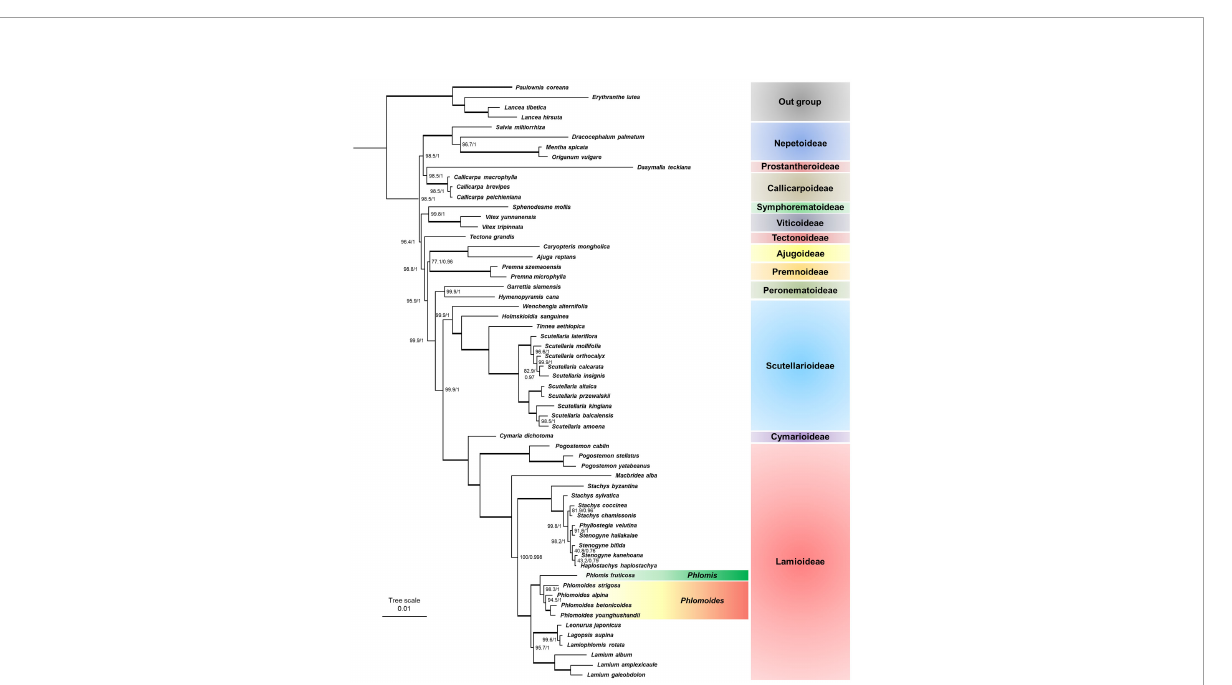
FIGURE 9 Phylogenetic tree based on chloroplast genomes of 56 Lamiaceae species. The topology of phylogenetic tree and the associated edge length is depicted. Maximum likelihood bootstrap support (MLBS) and Bayesian inference posterior probability (BIPP) are shown forward and backward on the right of bifurcation, respectively. Bold horizontal lines indicate clades with BIPP = 1.00 and MLBS =